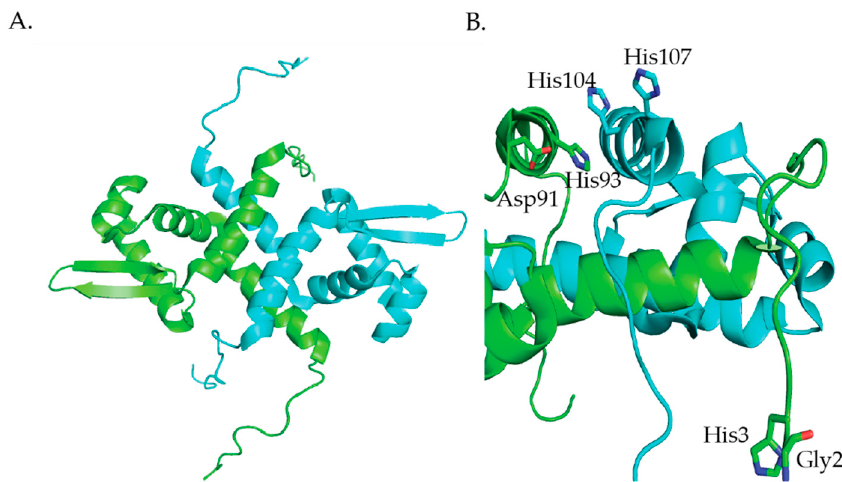
Figure 7. ( A ) NMR structure of apo M. tuberculosis NmtR (PDB ID 2LKP) [87]. NmtR monomers are colored in green and blue ( B ). Close-up of one of the nickel sites showing the nickel binding site. (Figure adapted with permission from Lee, C.W.; Chakravorty, D.K.; Chang, F-M.J.; Reyes-Caballero,